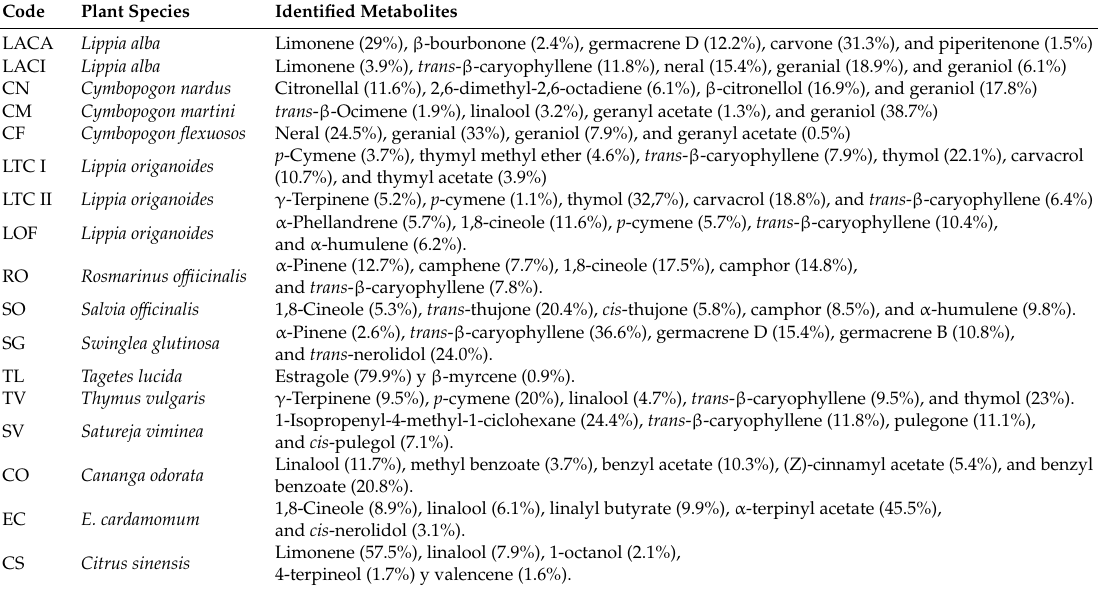
Table 1. Major chemical constituents present in the EOs assessed. Relative amount of each metabolite is reported in percentage (%).